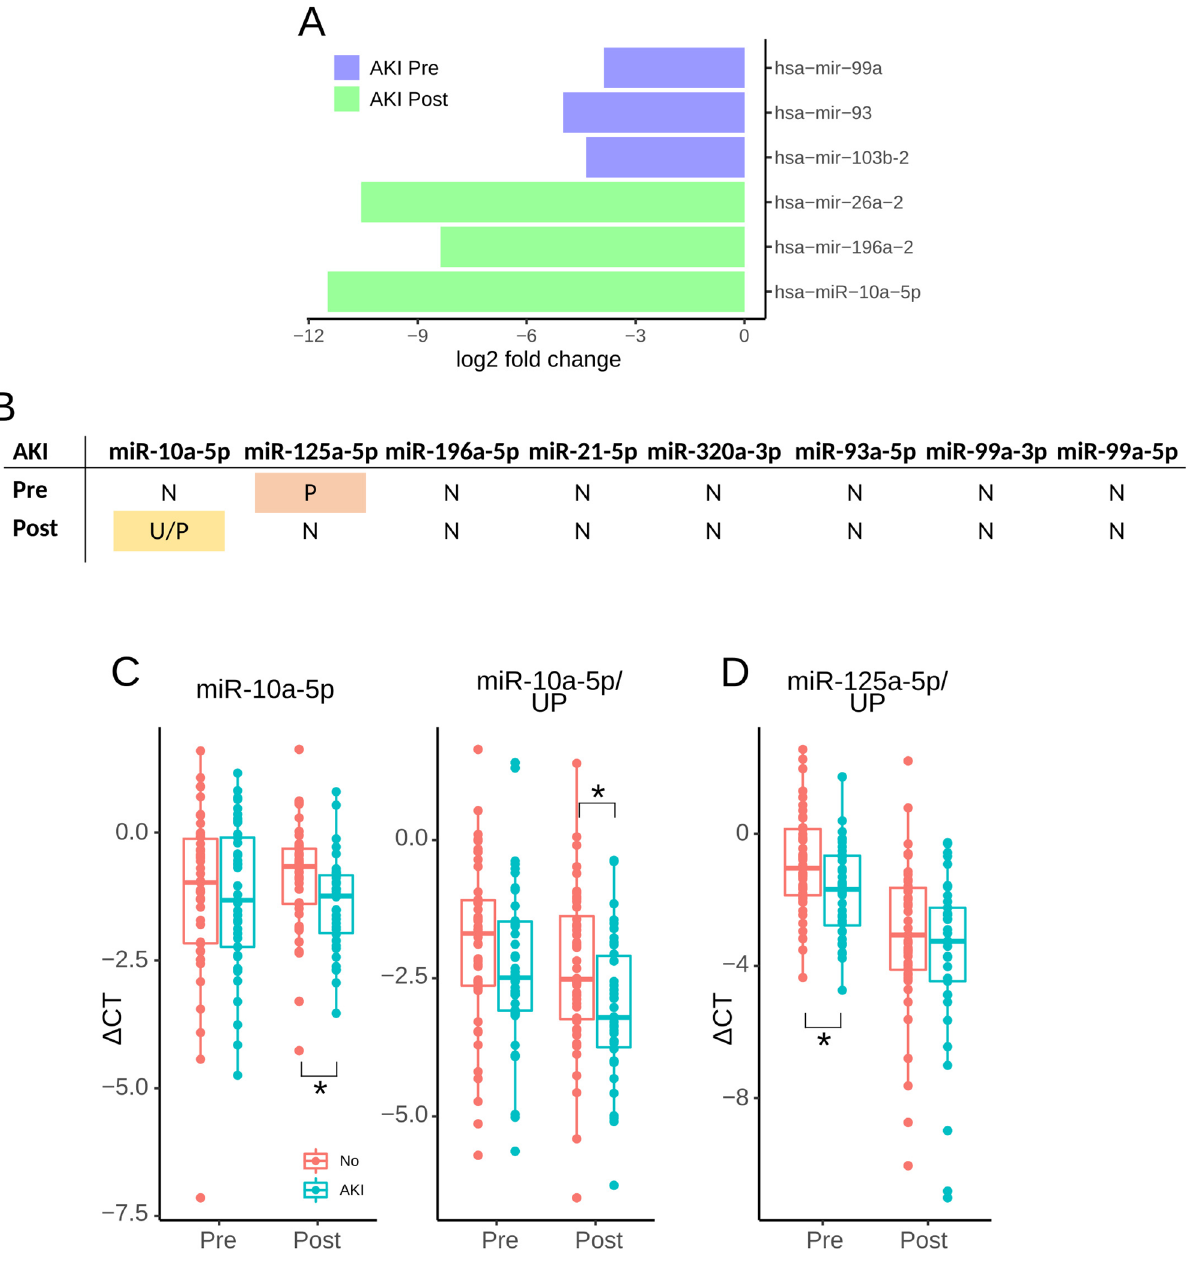
Figure 3. ( A ) Graphical representation of log2 fold changes of significantly different miRs. Negative values indicate lower expression levels in patients who developed AKI. ( B ) Summary of statistical analysis of qRT-PCR analysis of miR using unadjusted, EV or urinary creatinine-adjusted data. Yellow fields indicate a significant difference for two and pink for one adjustment. U unadjusted data, P urinary particle concentrations-adjusted data, N no difference. ( C , D ) Plots of miR-10a-5p and miR-125a-5p. Asterisks indicate a significant difference between AKI groups. UP indicates adjustment for urinary particle